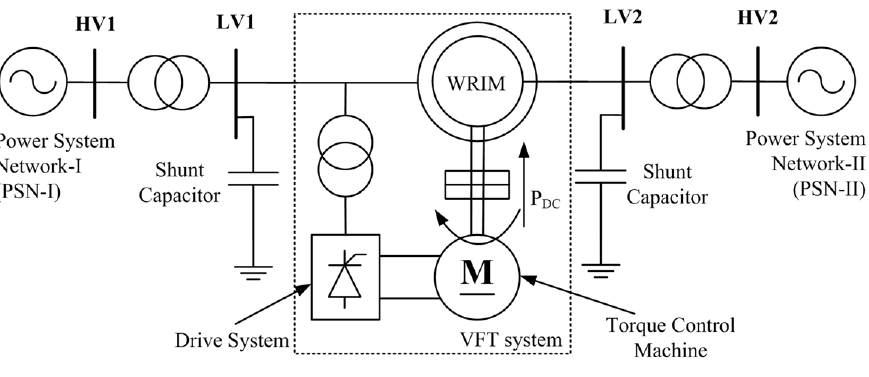
Figure 14. A VFT system interconnecting two power system